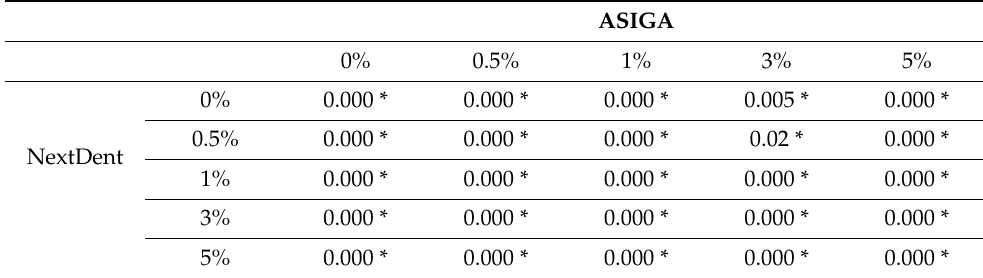
Table 5. Pair-wise comparison of concentration levels between the two materials.